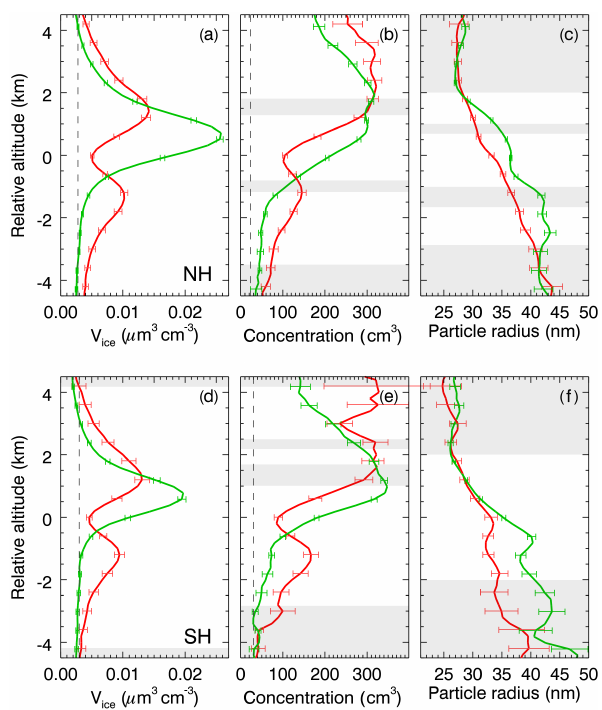
Figure 5. Vertical structures of the V ice (a, d) , particle concentra- tion (b, e) and effective radius (c, f) for the NH (upper panel) and SH (lower panel) respectively. Red profiles are averaged by all double- layer PMC profiles aligned to their troughs, while green profiles are averaged by single-peak PMC profiles aligned to their peaks. Grey dashed lines represent the thresholds of uncertainty. Error bars show the standard deviation of the mean. The grey translucent rectangular areas show the regions where the significances derived by t tests are larger than